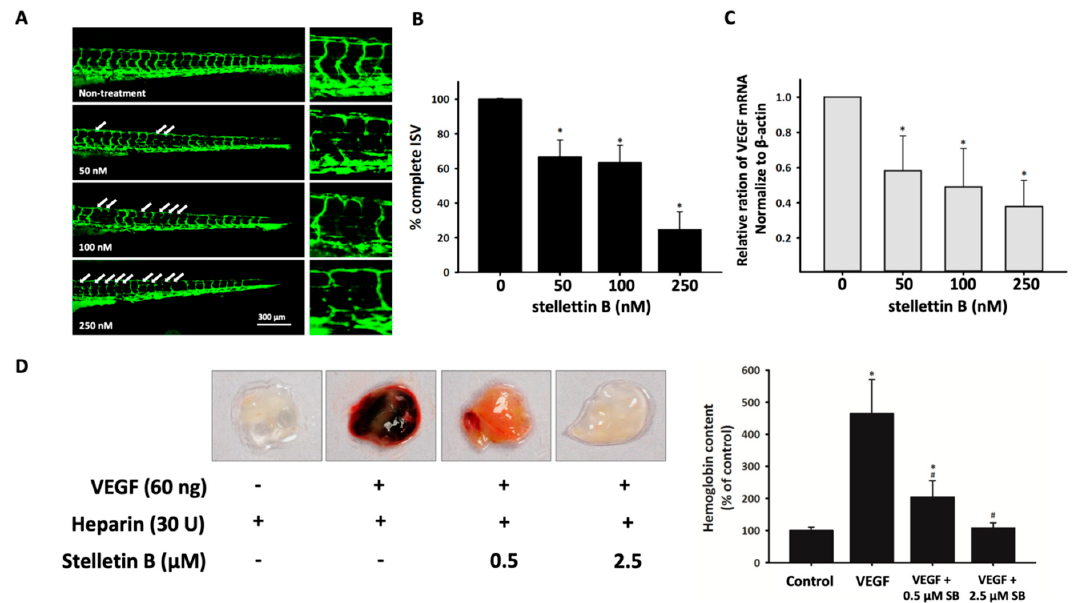
Figure 7. Stellettin B inhibits angiogenesis in zebrafish and mouse models. ( A ) Lateral view of Tg ( fli1 :EGFP) y1 zebrafish embryos at 72 hpf immersed in Hank’s buffer with 0, 10, 50, 100, or 250 nM stellettin B treatment. Scale bar = 300 µ m. ( B ) Percentage of complete intersegmental vessels (ISVs) in each group. Values are expressed as the mean ± SD ( n = 12). ( C ) Real-time quantitative polymerase chain reaction (PCR) analysis of VEGF expression. Values are expressed as the mean ± SD ( n = 3). * p < 0.05 relative to the nontreatment group. ( D ) Effect of stellettin B on in vivo angiogenesis, determined